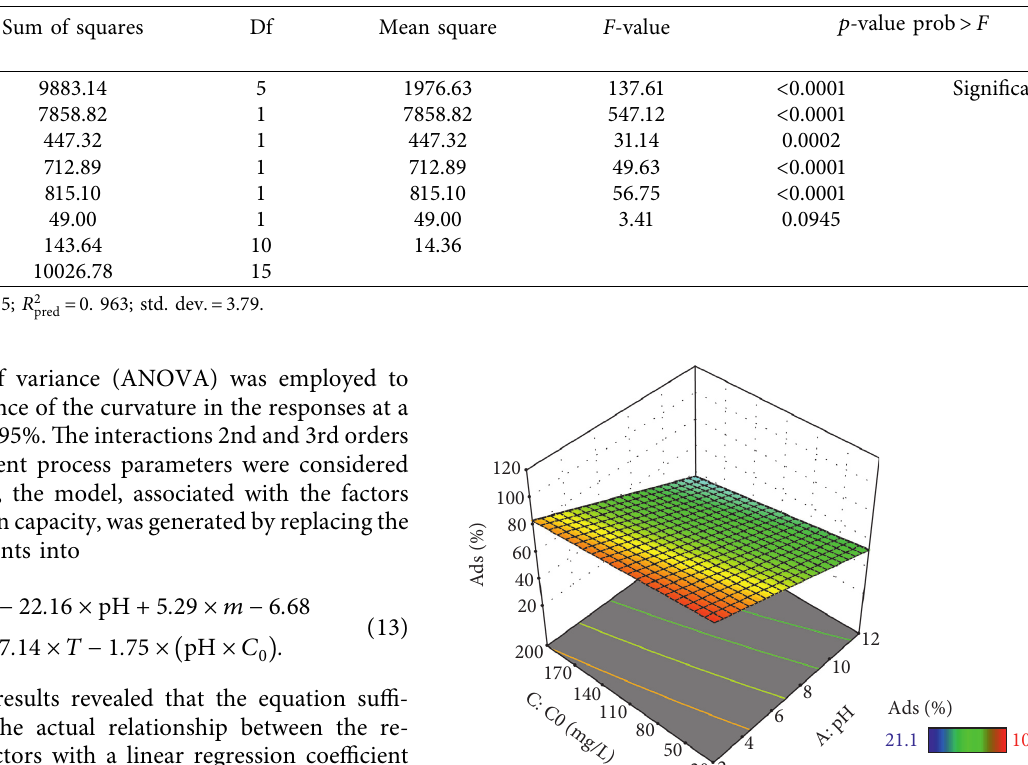
Table 10: Analysis of variance for the responses.